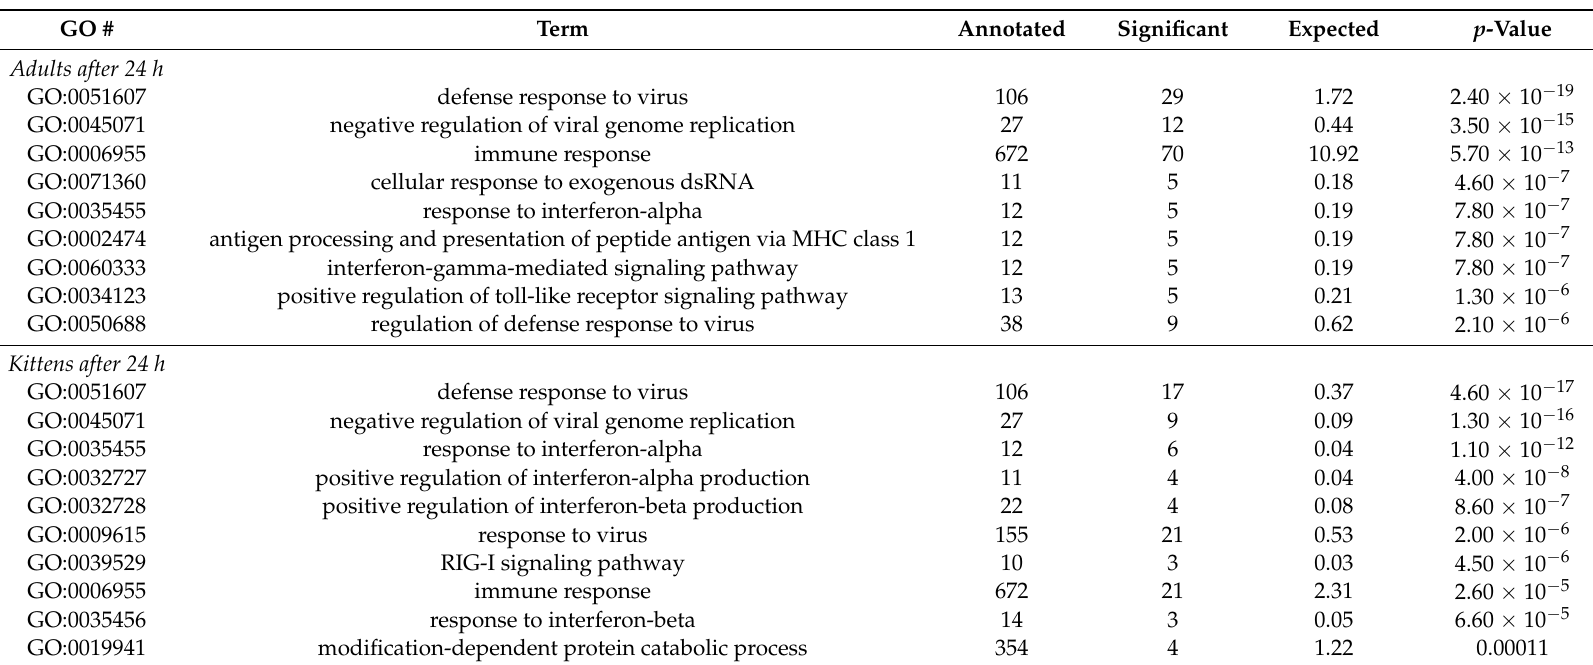
Table 5. Significantly enriched Gene Ontology (GO) terms in the category “Biological Process” for upregulated genes in GI.1-infected